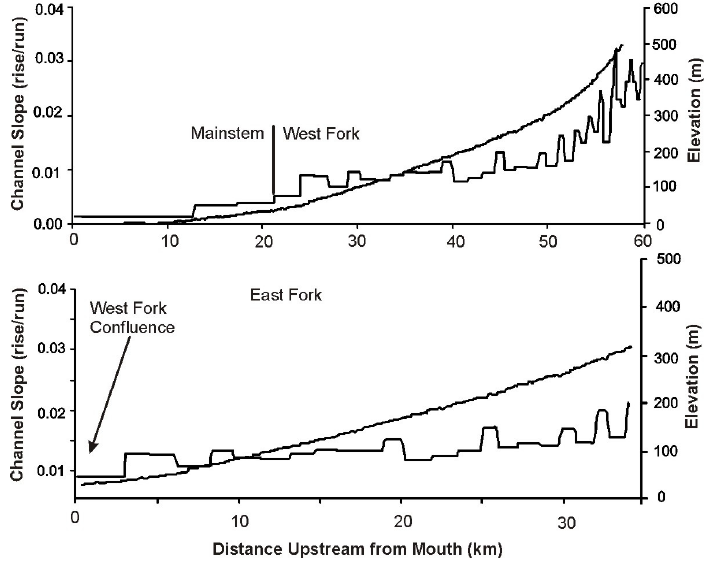
Fig. 2. The channel longitudinal profiles and the associated slope gradients (rise/run) in the “Mainstem”, “West Fork” and “East Fork” channels were calculated using a 5-m digital elevation